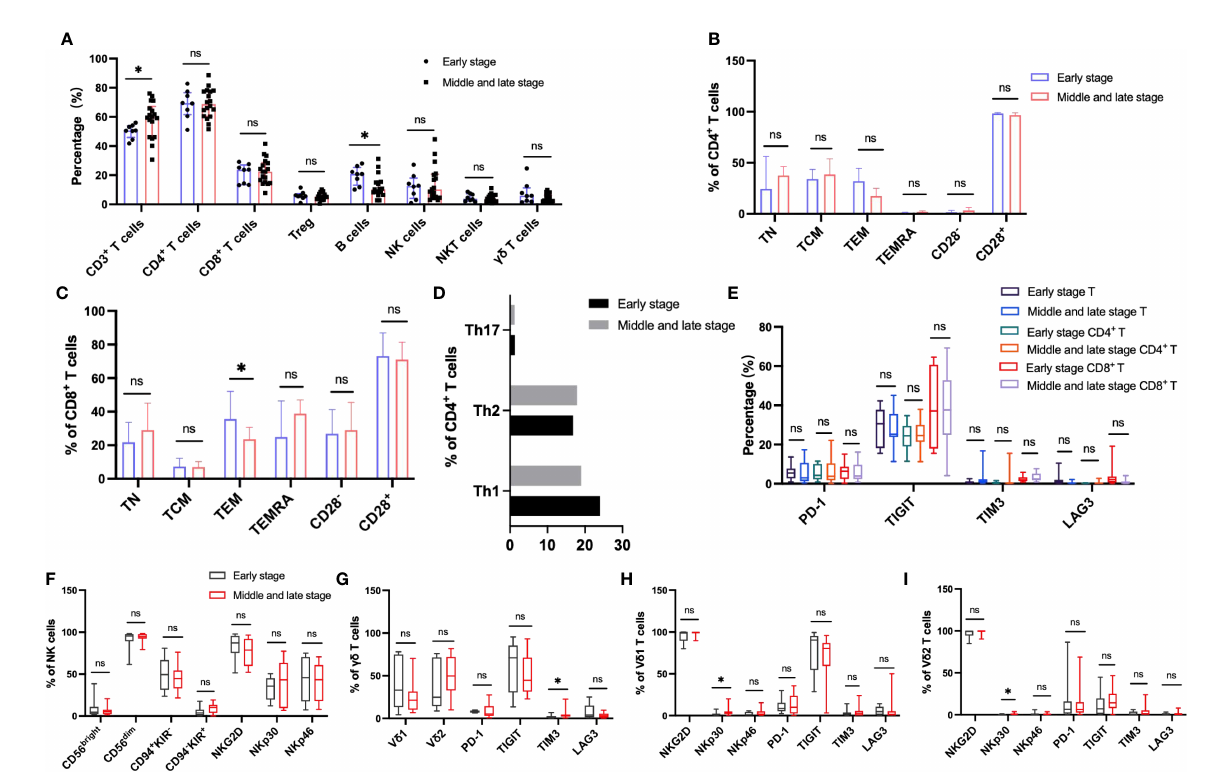
FIGURE 8 Circulating lymphocytes and their immunophenotypic characteristics in patients with early and advanced HBV-HCC. (A) The frequencies of ab T, B, NK, NKT and gd T cells in the two groups. (B, C) The expression of CD28, CD45RA and CCR7 on the surface of CD4 + T cells and CD8 + T cells in the two groups. (D) The frequency of CD4 + T cell subsets in the two groups. (E) Differences in the expression of inhibitory receptors on the surface of peripheral blood CD3 + T cells, CD4 + T cells, and CD8 + T cells between the two groups. (F) The expression of cytotoxic and activating receptors of circulating NK cells in two groups. (G – I) Differences in the expression of activated receptors and inhibitory receptors on the surface of gd T cells and its subsets V d 1 and V d 2 cells between the two groups. T test or Mann-Whitney U test was used to determine statistical differences between the two groups. * p <0.05. ns, not signi fi